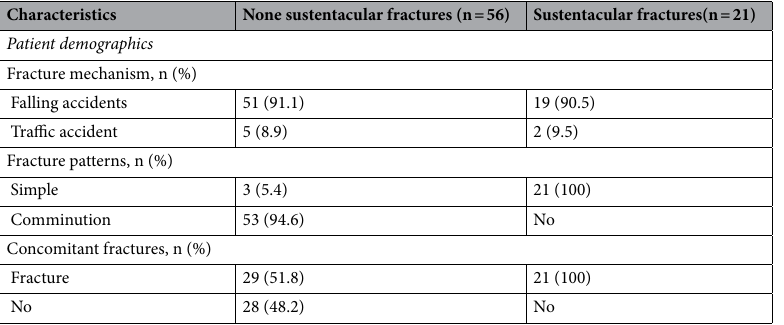
Table 1. Patient characteristics (including mechanism of injury, fracture morphology and associated injuries) of calcaneal fractures with and without sustentacular involvement.